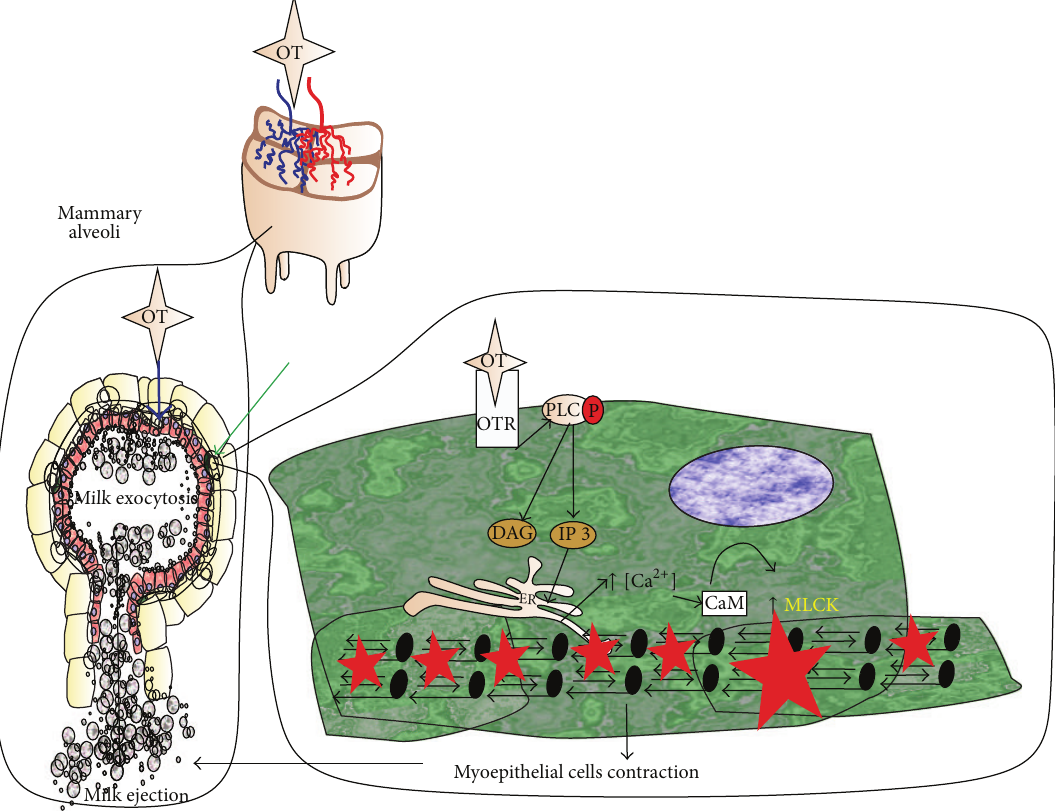
Figure 3: Proposed mechanism of action of oxytocin (OT). This hormone induces contraction of the myoepithelial cells (green arrow), via a G protein receptor. OT also induces exocytosis of milk in MEC (blue arrow) by intracellular Ca 2+ increased pathways. Myoepithelial cells contraction and MEC exocytosis induce milk ejection; the continued milk ejection results in a decrease of a protein milk synthesis reversible blocker: feedback inhibitor of lactation (FIL), and this milk and FIL removal of mammary gland will promote then the milk synthesis.